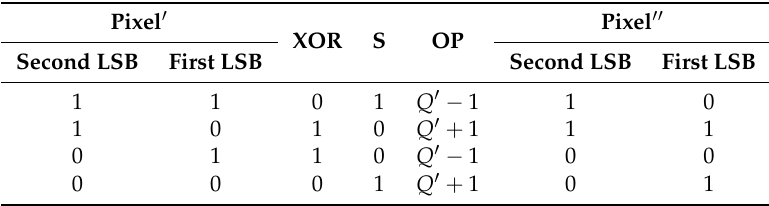
Table 2. Rule of OPAP for first and second LSB.